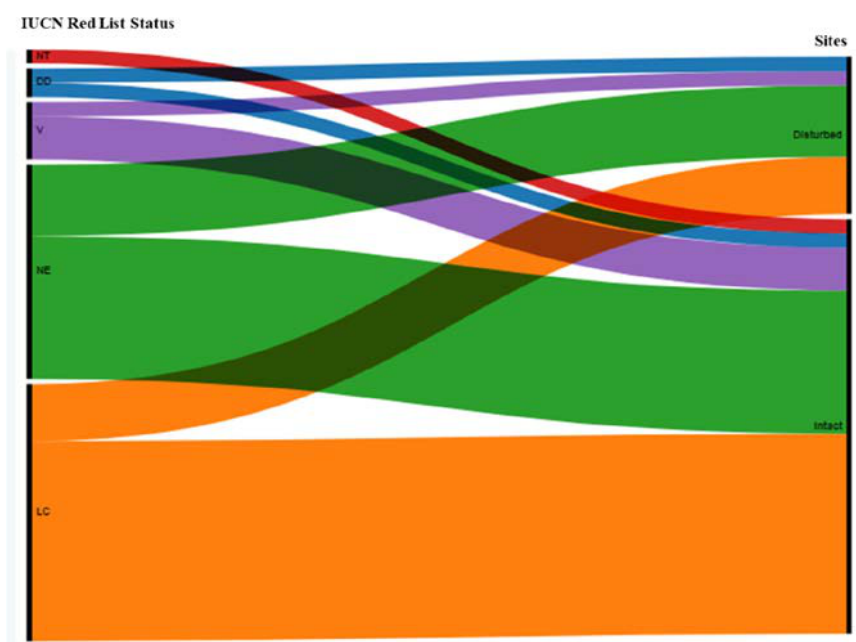
Fig. 8: Fish IUCN Red List Status compositions at disturbed (a) and intact (b) sites on West Java coast (DD: data deficient; NE: not evaluated; LC: least concern, V: vulnerable)